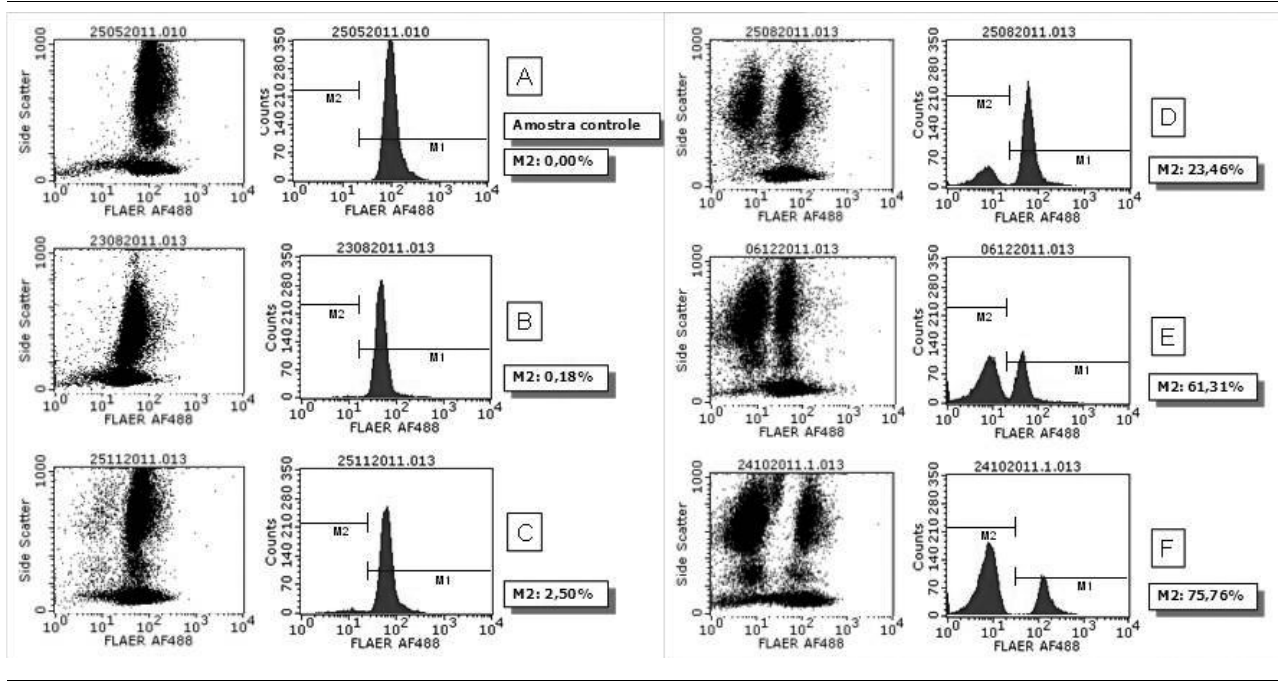
figurE 4 – Acquisition graphs and histograms of analysis, illustrating staining of neutrophils with FLAER, in different situations A) individual of the control group; B) and C) detection of PNH clones with small proportions of altered cells; D) and F) detection of larger PNH clones, with increasing proportions of altered cells. Graphs B to F represent analysis of five samples of the study, identified as positive for PNH clone FLAER: fluorescent aerolysin reagent; PNH: paroxysmal nocturnal